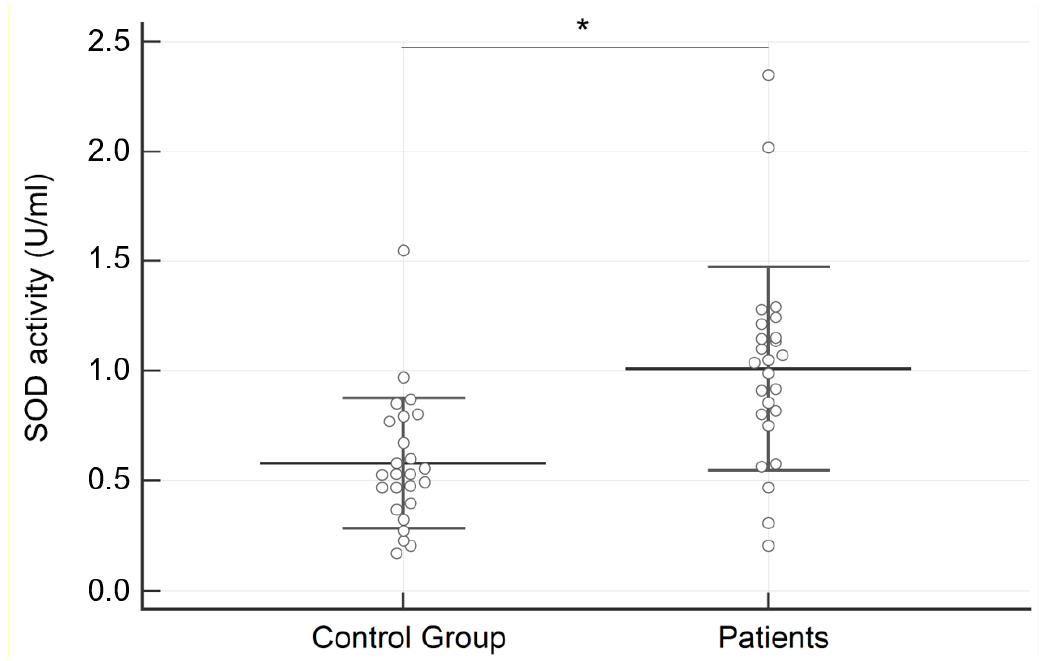
Figure 1. Results of the superoxide dismutase activity (SOD) expressed in U/mL in the two examined groups. Data are reported as Mean ± SD. * = p < 0.001.